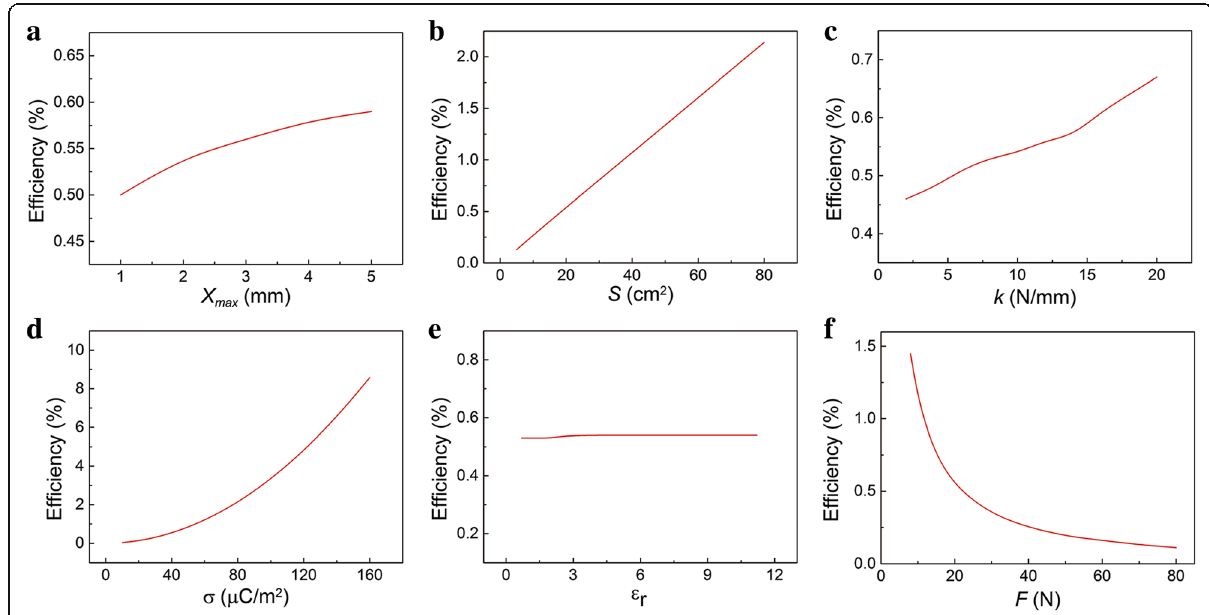
Fig. 6 Conversion efficiency η of TENG. The relationship of the calculated conversion efficiency with the parameters a x max , b S , c k , d σ , e ε r , and f